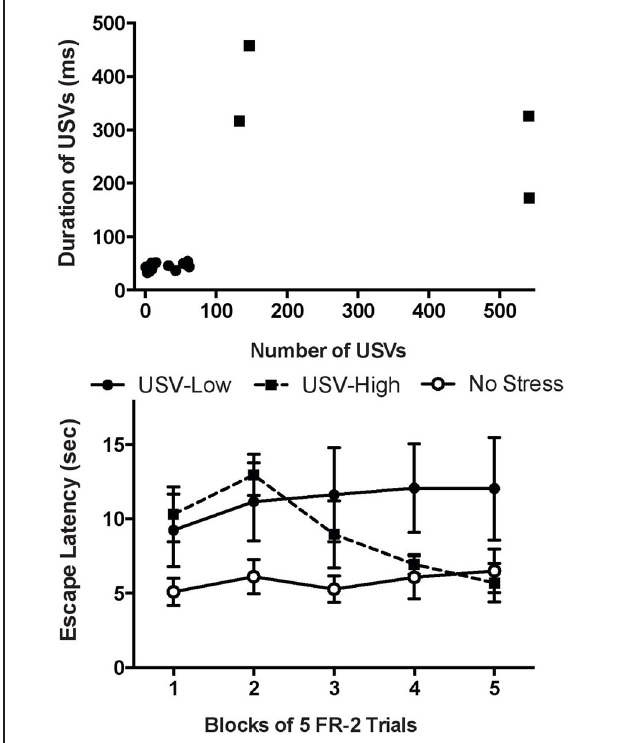
FIGURE 3 | Predicting resilience in the Swim Stress Paradigm. Top: A scatter plot characterizing the ultrasonic vocalizations (USVs) of the rats in the swim stress group recorded during stress exposure. Rats were categorized as USV-High rats (black squares) or USV-Low (black circles). USV-High rats produced a large number of long-duration vocalizations while USV-Low rats emitted few, short-duration vocalizations. Plotted are the number of ultrasonic vocalizations vs. the average duration of the vocalizations for each rat. Bottom: Mean ( ± SEM) time to escape in the swim escape test (SET). Rats in the USV-Low group displayed a detriment in learning while the USV-High group appeared resilient and performed similarly to the no stress control group. The no stress group was exposed to the swim stress apparatus, but was never exposed to swim (adapted from Drugan et al.,